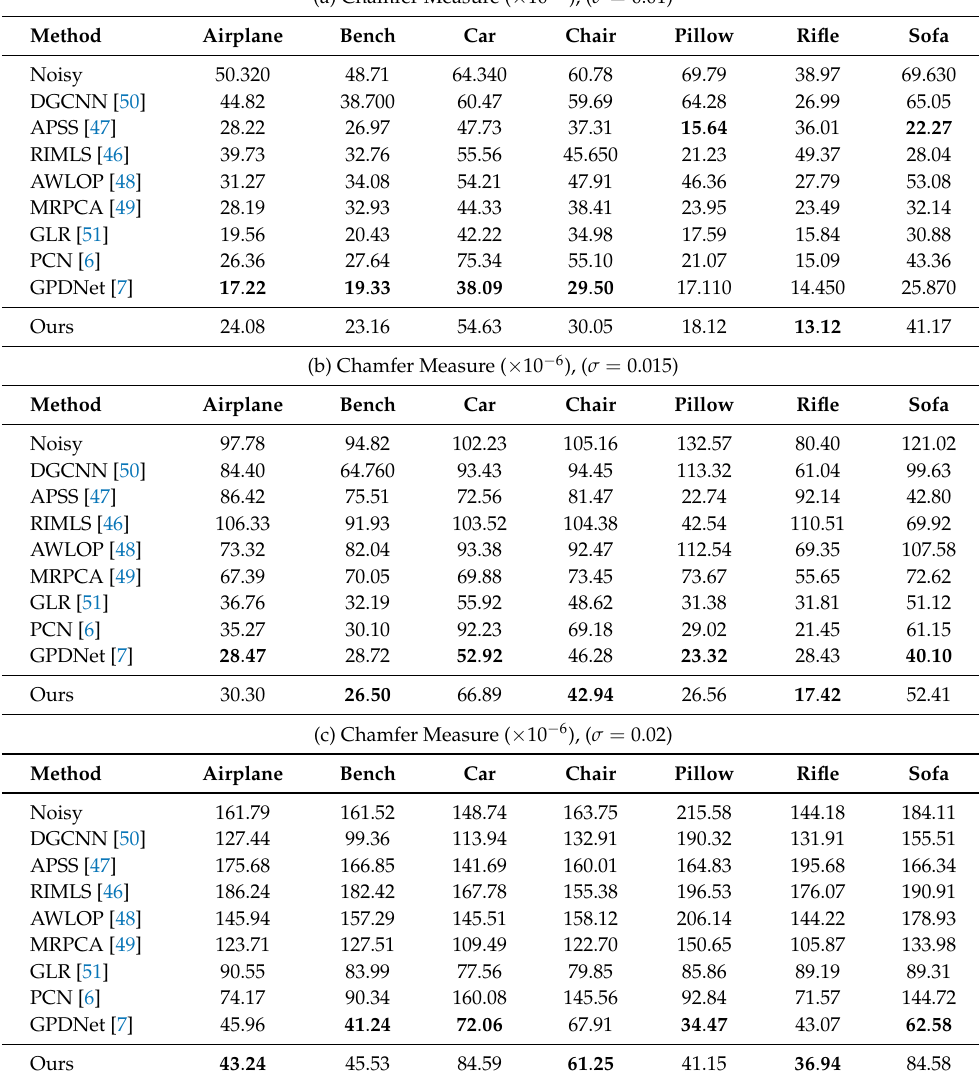
Table 1. Denoising performance of our method (CMD-Net) on the GPDNet dataset is compared using the Chamfer Measure evaluation metric. The numbers in this table are C2C scores (see the metric in Section